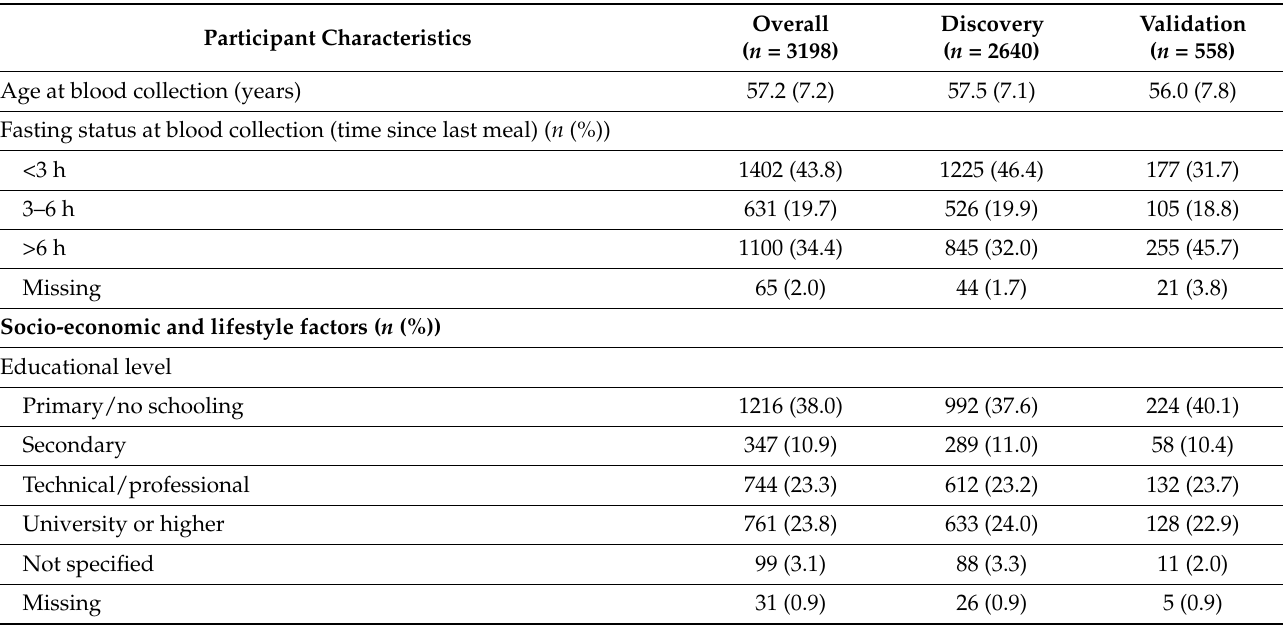
Table 3. Main characteristics of men included in the analysis, overall and separately in discovery and validation